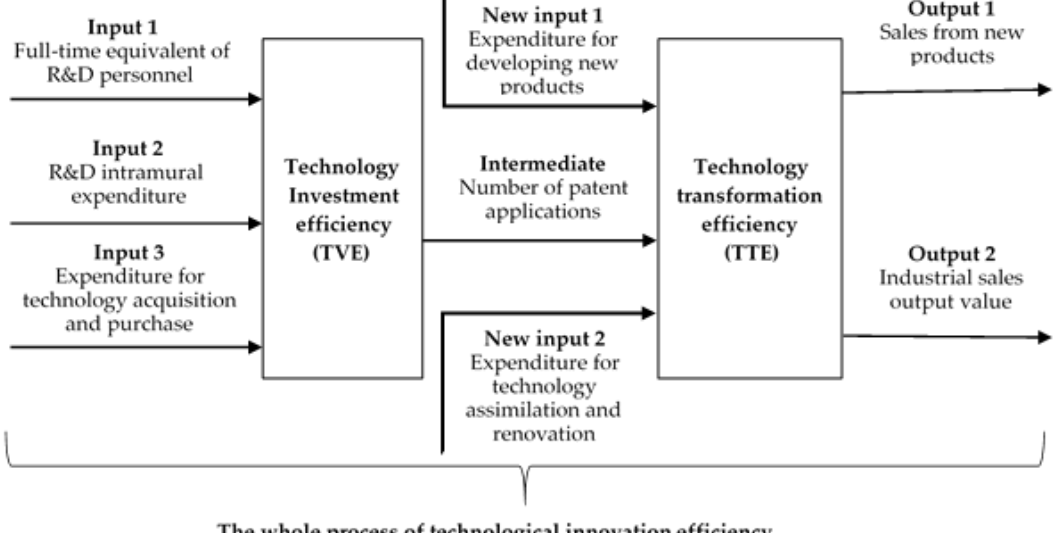
Figure 2. Decomposition of Technological Innovation.